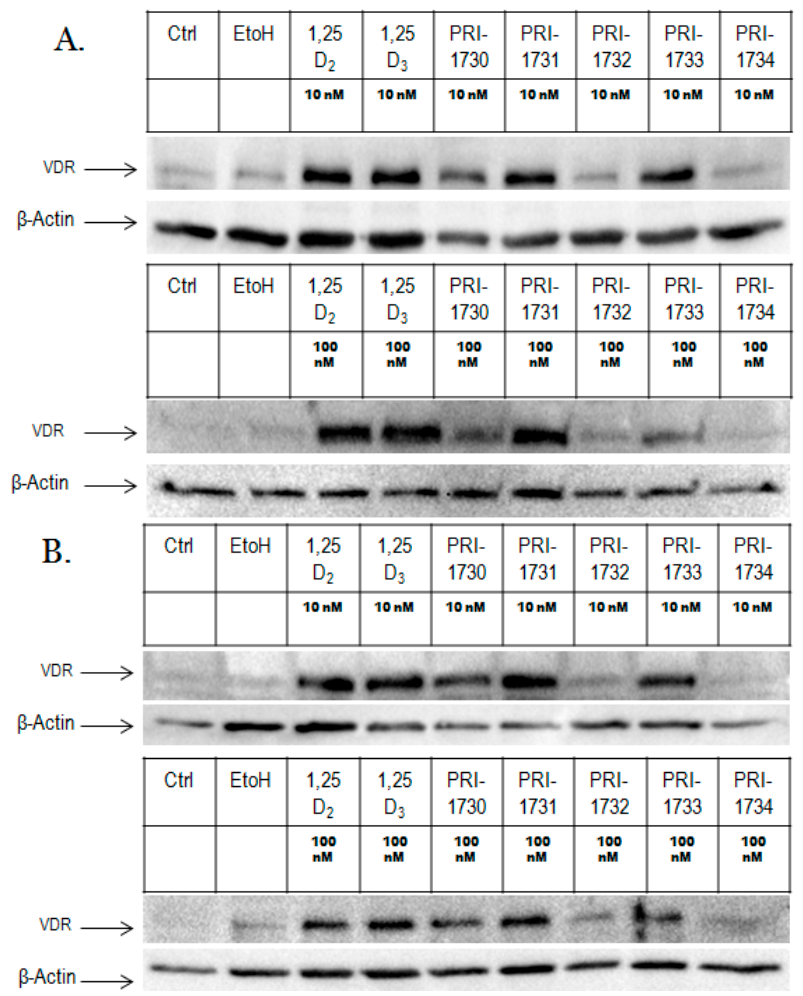
Figure 4. Nuclear localization of VDR protein in HL60 exposed to 1,25D 2 , 1,25D 3 or analogues. HL60 cells were exposed to compounds at 10 nM and 100 nM concentration for 24 h ( A ) and 72 h ( B ) and then expression of VDR was determined in the nuclear fractions.